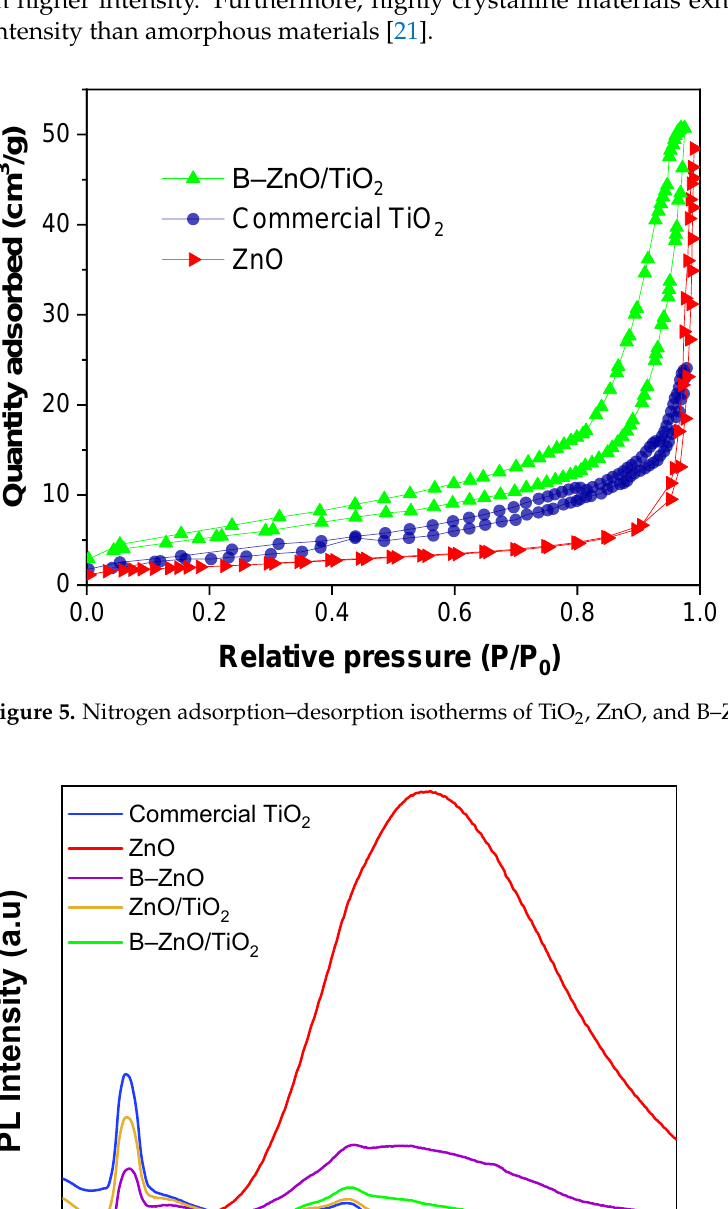
Figure 6. PL spectra of TiO 2 , ZnO, B–ZnO, ZnO/TiO 2 , and B–ZnO/TiO 2 .